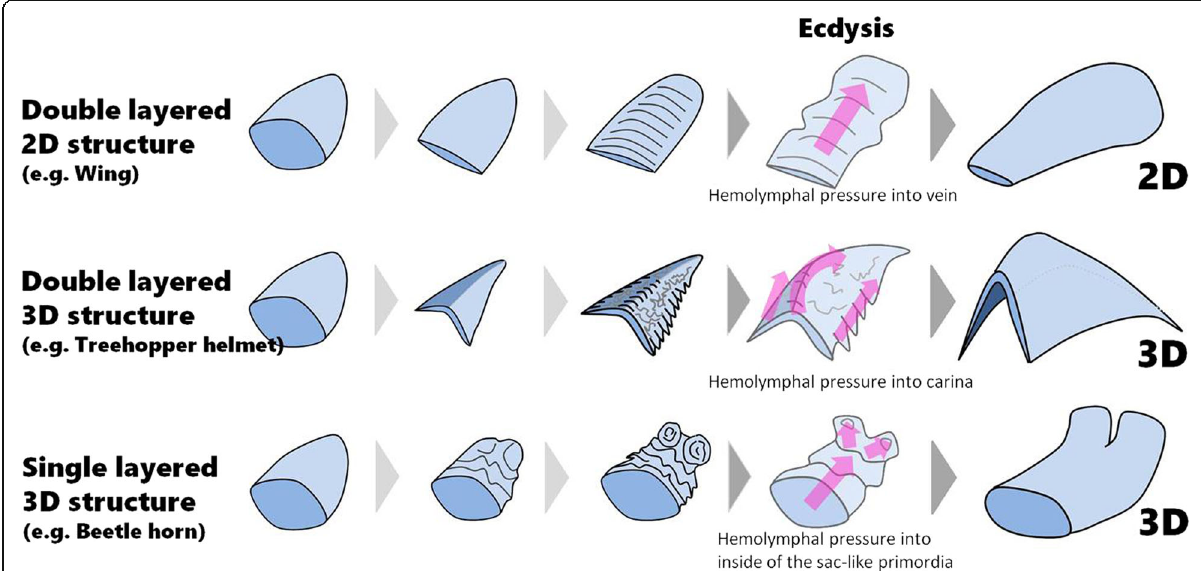
Fig. 7 Schematic diagram of 2D and 3D morphogenesis of insect adult structures via “ folding and extension ” . All structures essentially started from a sac-like monolayer structure, but the final structures differ (2D or 3D, monolayer or double layered). In a bi-layer 2D structure like an insect wing, internal space disappears during development by connecting the upper and lower layers. Then, flat bi-layer primordia form relatively simple parallel furrows which enable primordia to enlarge in a single direction. In a bi-layer 3D structure like the treehopper helmet, upper and lower layers stick together to form a bi-layer sheet. In contrast to the wing, this bi-layer structure has a 3D shape. The macro and micro furrows determine the expansion rate in multiple direction to form its 3D shape. In a monolayer 3D structure, the inner space of the primordium does not disappear during development. Furrows are formed in the surface of the primordium by bending a single layer of epithelium and are extended by hemolymphal pressure at